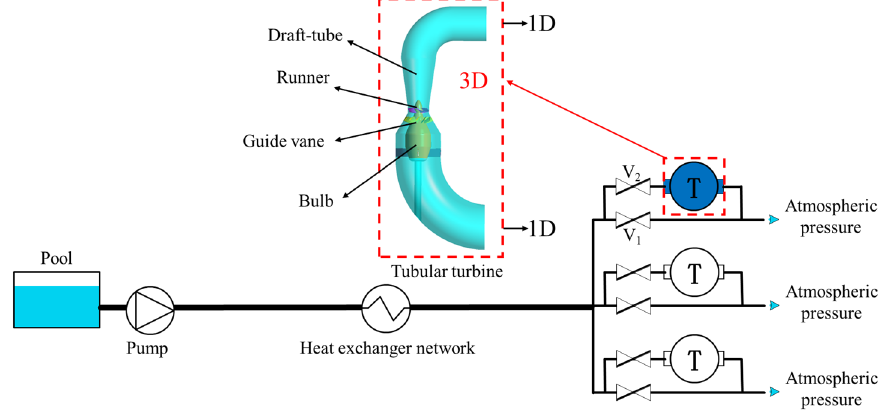
Figure 8. Schematic of the Coupled model.